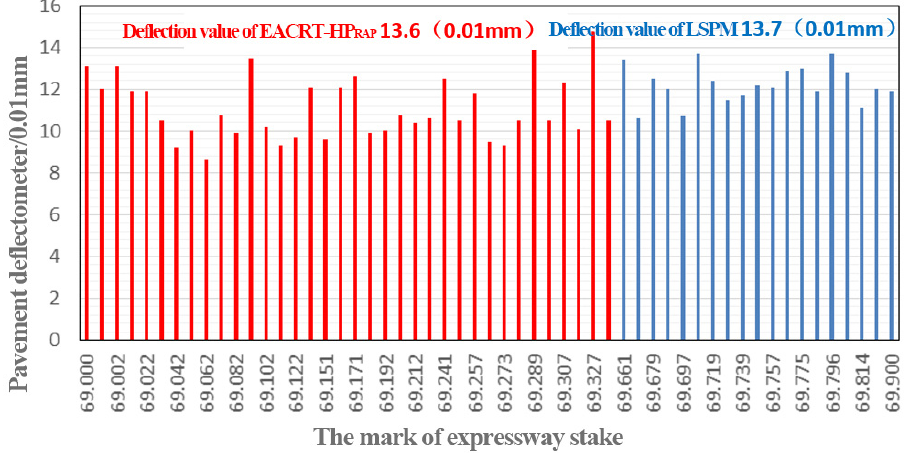
Figure 5. Comparison of the deflection values of the two test